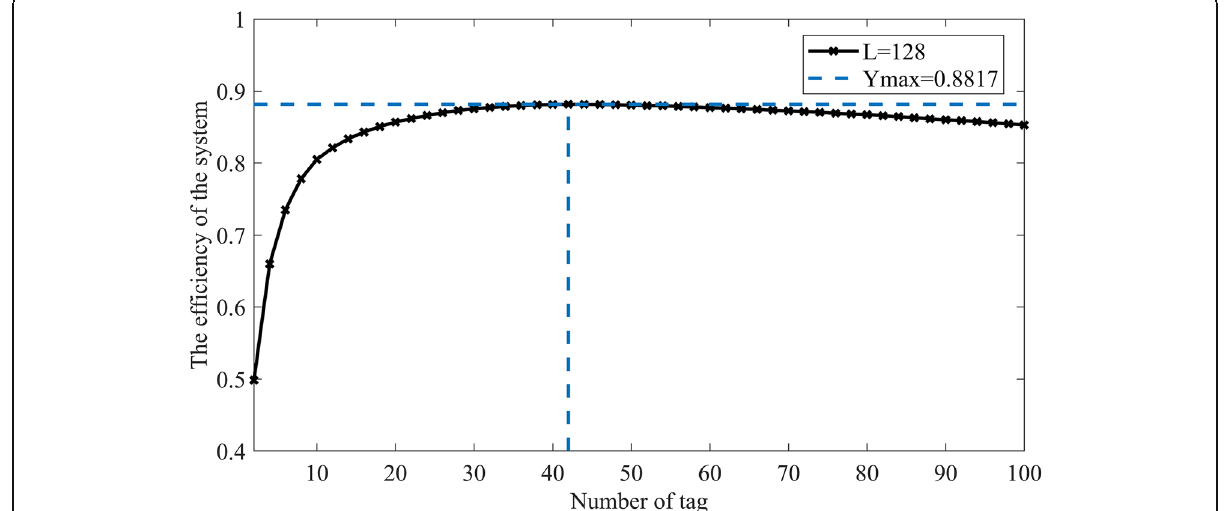
Fig. 11 Multiple identifications of system efficiency versus the number of